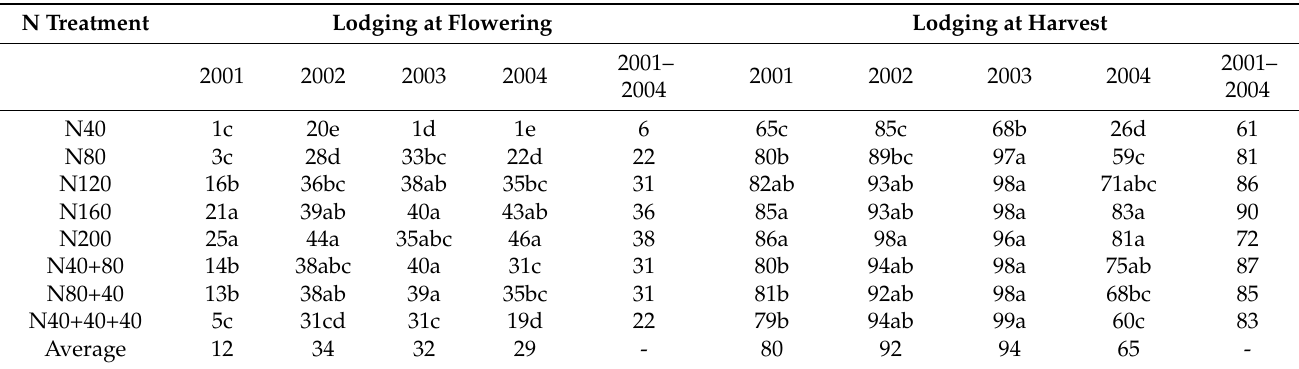
Table 2. Lodging at flowering and at harvest within years and nitrogen (N) treatments and as an average of years. Different letters within each year show significant differences at a 5 percent level.